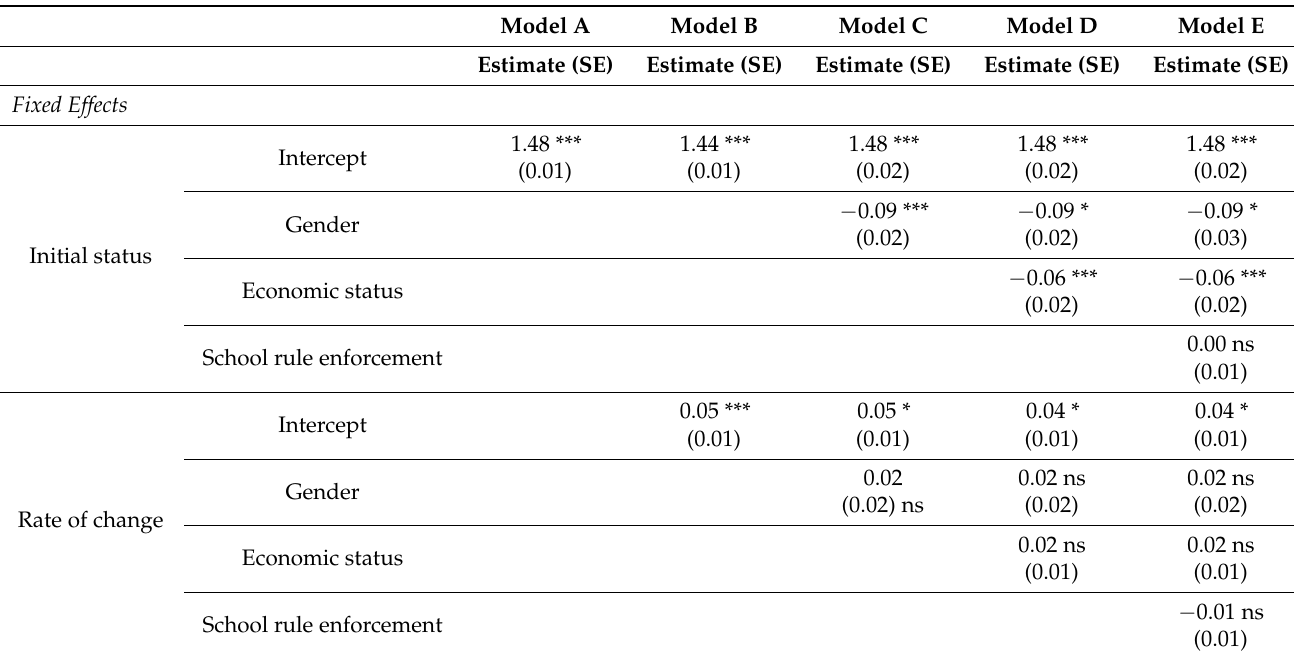
Table 4. Results of fitting a multilevel model for change to the traditional victimization data: fixed effects, variance components and goodness of